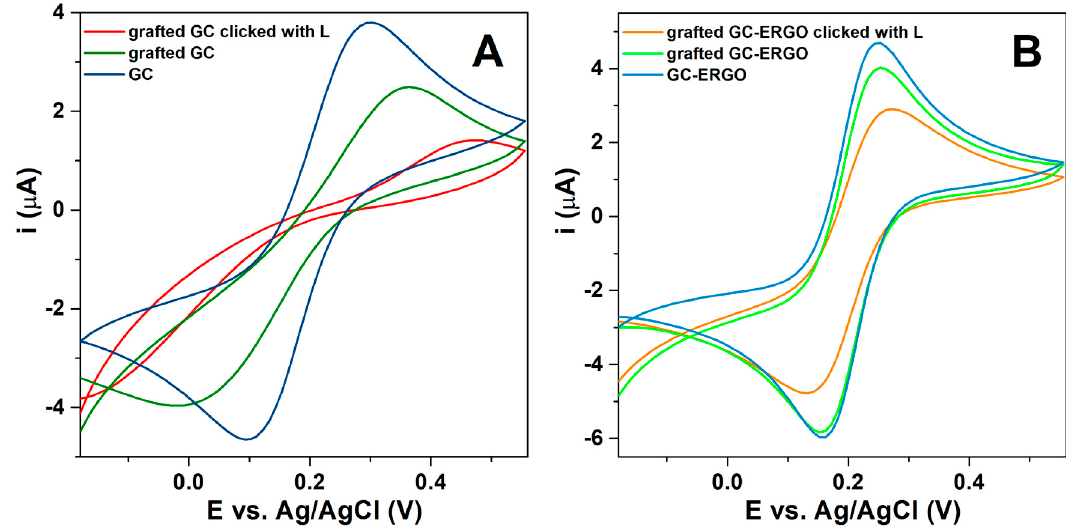
Figure 3. Cyclic voltammograms recorded in 1 mM Fe(CN) 6 3 − , 0.1 M KCl solution (20 mV s − 1 ), at ( A ) GC and ( B ) GC-ERGO electrodes, after different modification steps.